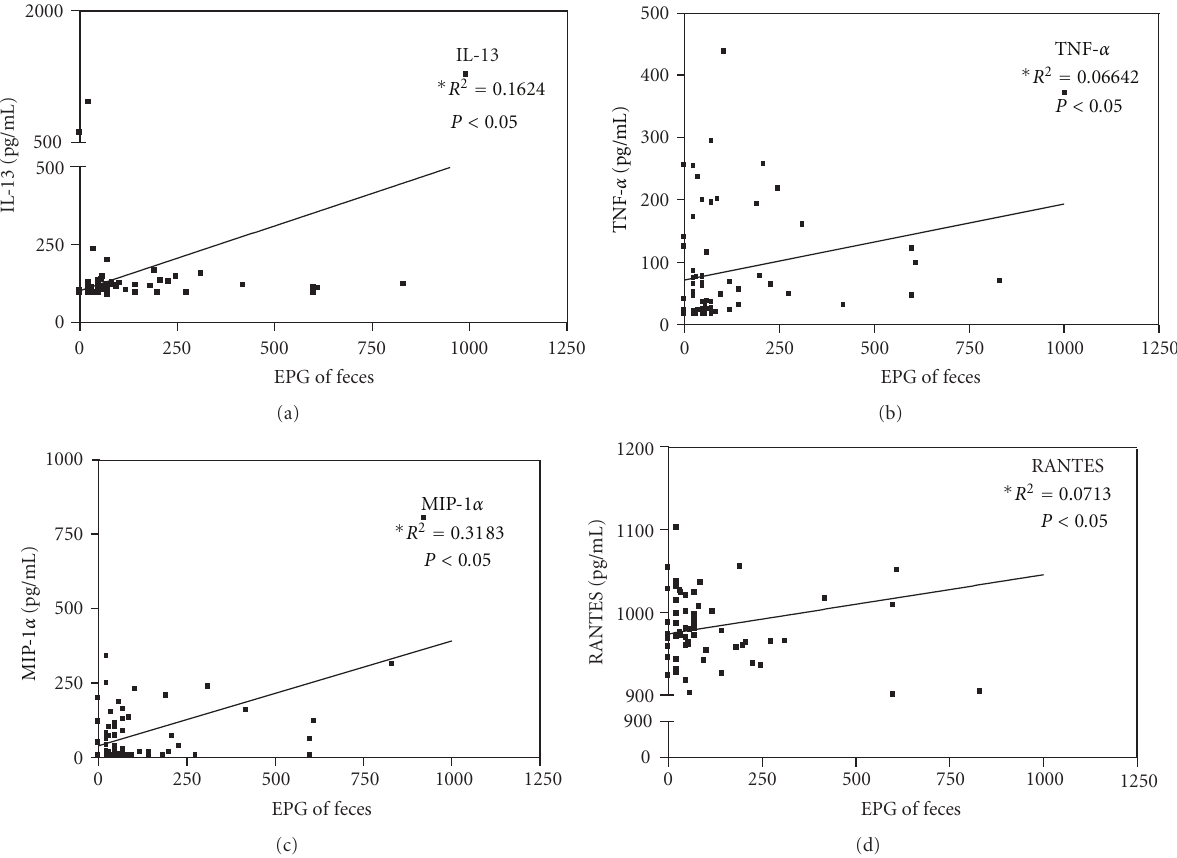
Figure 3: Correlation between serum levels of IL-13, TNF- α , MIP-1 α , and RANTES ( n = 65) and S. mansoni parasite burden. P < 0 . 05 indicates statistically significant di ff erences (Linear